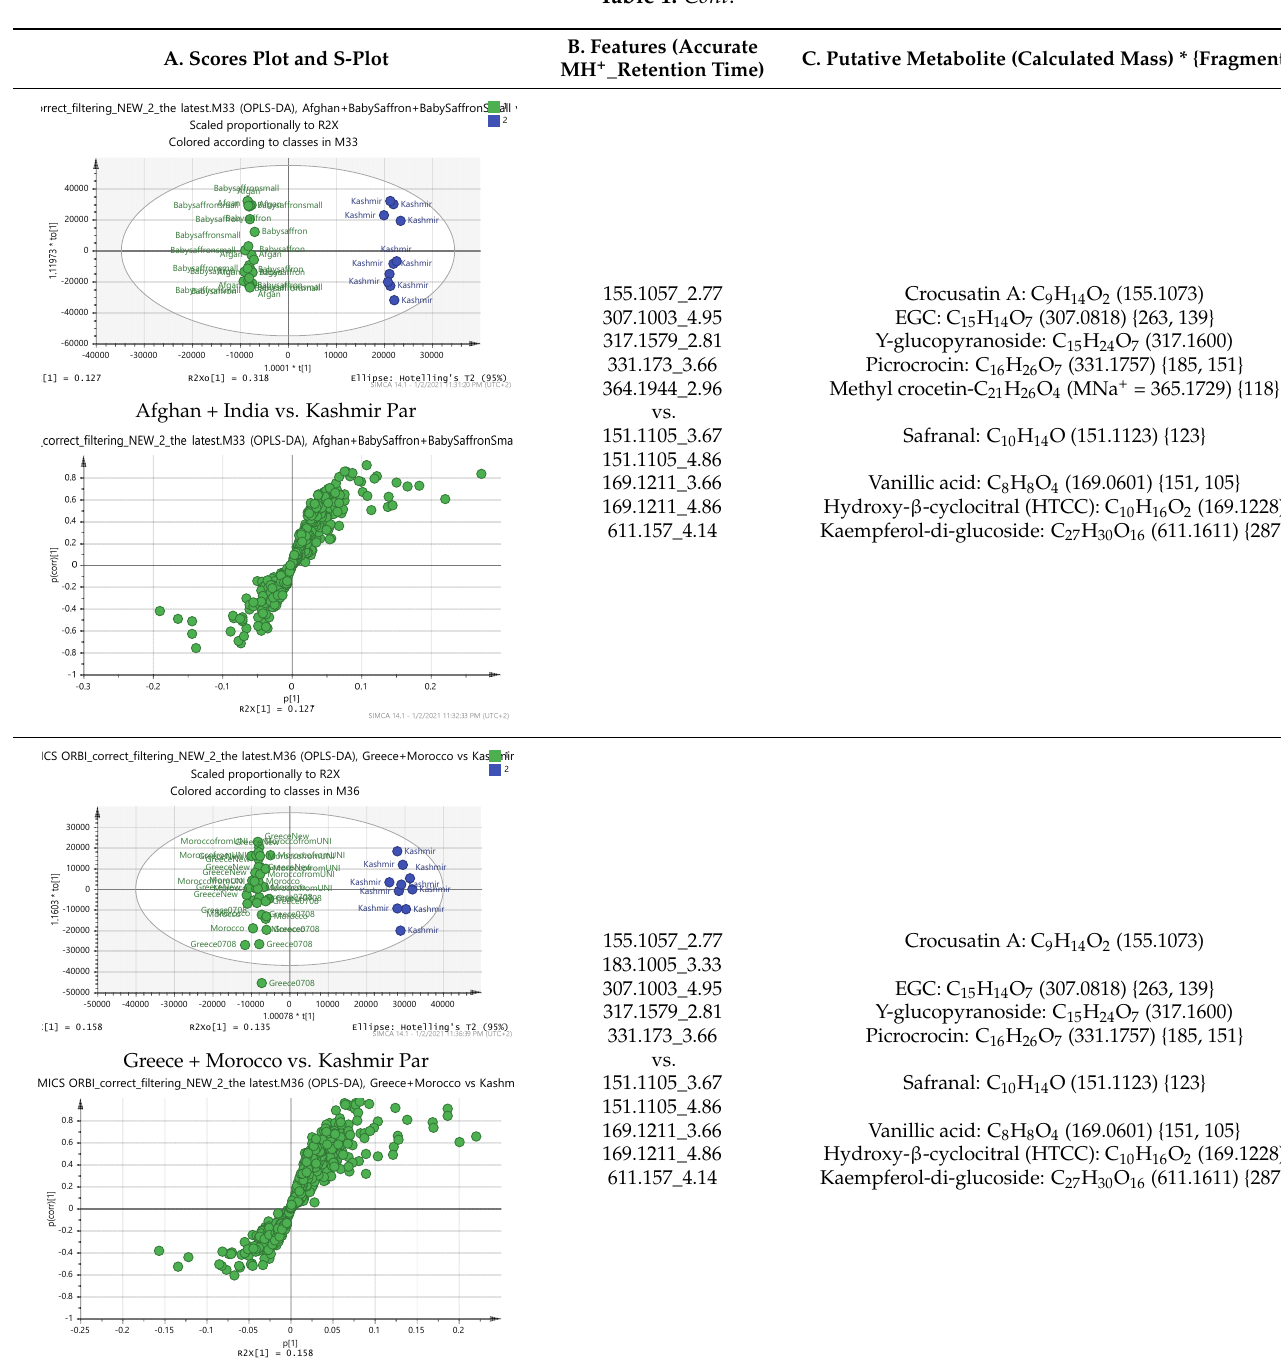
Table 1. Cont . C. Putative Metabolite (Calculated Mass) * {Fragment} 1